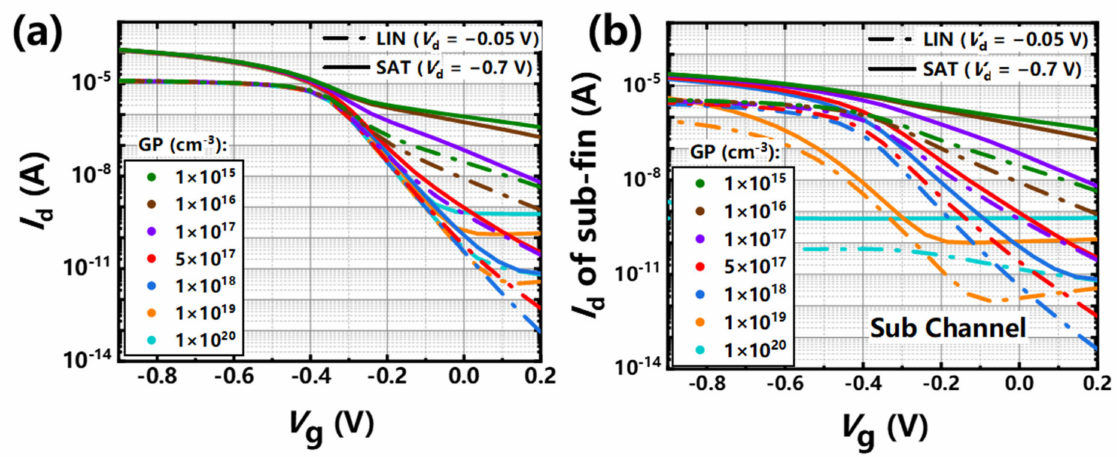
Figure 11. I d - V g curves of 12-nm- L g, ( a ) NS-FETs and ( b ) sub-channel with different GP doping